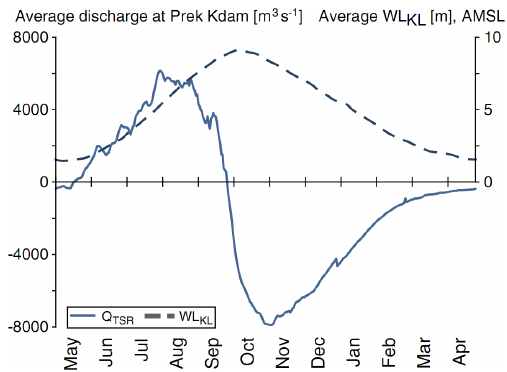
Figure 5. Daily averaged (from 1997 to 2004) water discharge hy- drograph at Prek Kdam and water level variation at Kampong Lu- ong (Kummu et al., 2014). The solid line presents the river flow entering Tonle Sap Lake at the Prek Kdam station, and the dashed line shows water levels at the Kampong Luong